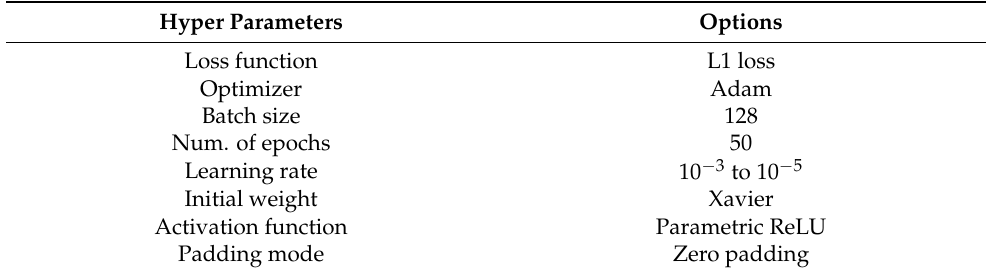
Table 2. Hyper parameters of the proposed DCRN.